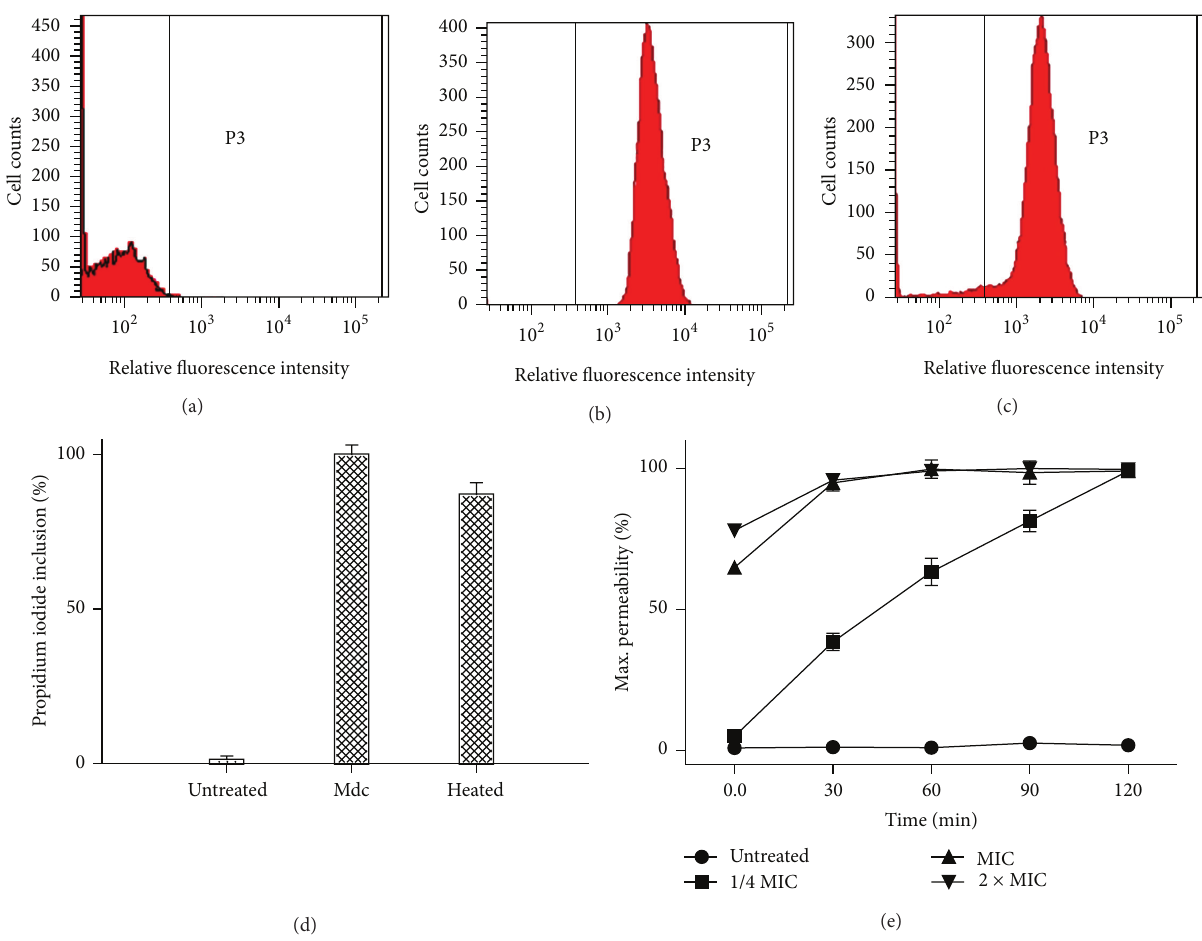
Figure 3: Effect of Mdc on the membrane permeability of A. baumannii GIM1.650 analyzed by the flow cytometer. The relative fluorescence intensities within the P3 regions were taken as PI-positive cells. (a) Untreated cells control, (b) cells treated with 4 𝜇 g/mL Mdc at 37 ∘ C for 1 hour, (c) dead control (cells heated at 70 ∘ C), (d) percentage of cells stained with propidium iodide (PI), and (e) kinetics of Mdc membrane permeability against A.